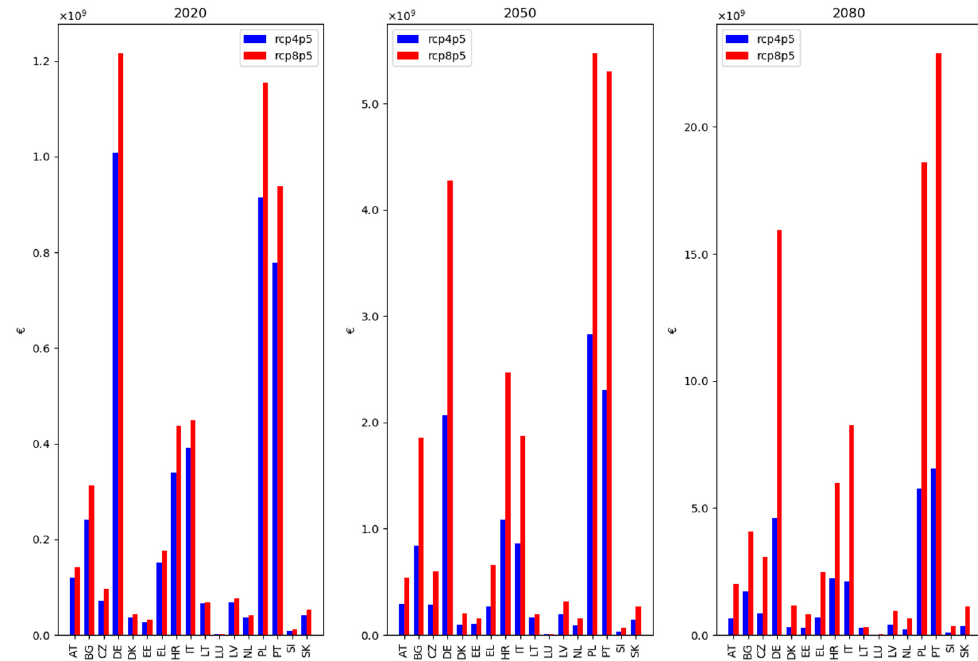
Figure A3. Uninsured annual flood risk for EU countries with voluntary insurance systems, under soft reinsurance market conditions, for RCP4.5 (blue) and RCP8.5 (red), for 2020, 2050, and 2080. Countries that provide public reinsurance for flood insurance are excluded here, as these are not exposed to global reinsurance market volatility resulting from large natural catastrophes. Additionally, countries